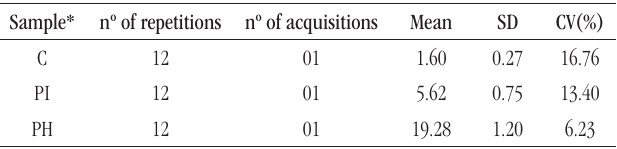
tABLE 2 – Accuracy of reticulocyte counts by the automated protocol for FC using AO (new protocol)